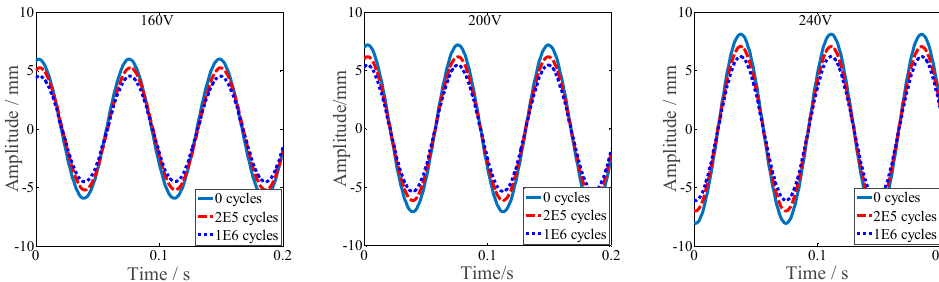
Figure 5. Tip displacement time history of the beam specimen actuated by MFC under cyclic load (stress amplitude 18 MPa).